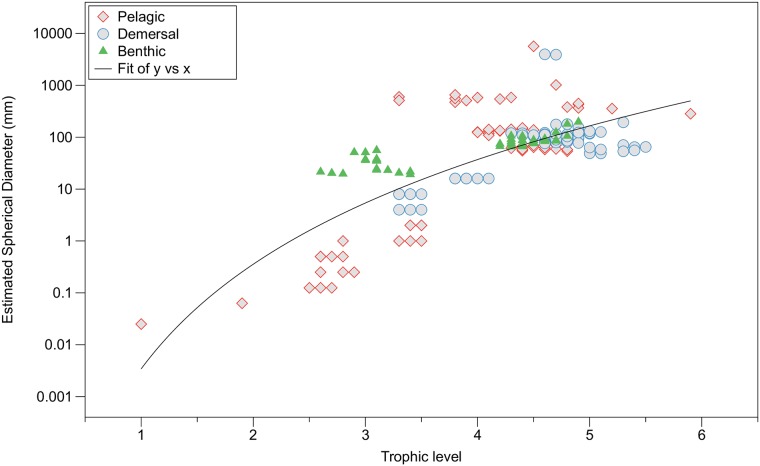
The relationship between the estimated spherical diameter (ESD) of an organism and its calculated trophic level from δ15 N values, for that portion of the food web from the outer Bay of Fundy where stable isotopes were measured.Y = 0.003X6.7, r2 = 0.69, n = 202.